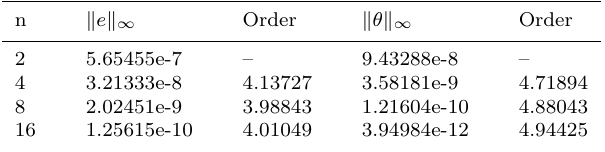
Table 3. Numerical results for example 2.